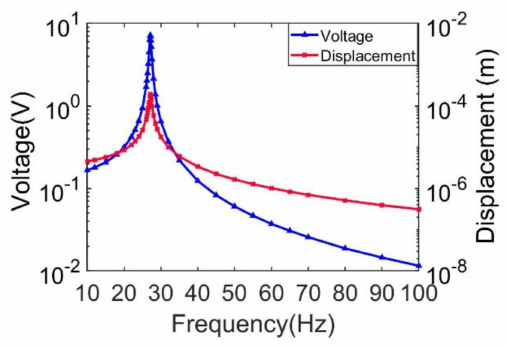
Figure 5. Simulation results of transverse deflection versus frequency at L/2.